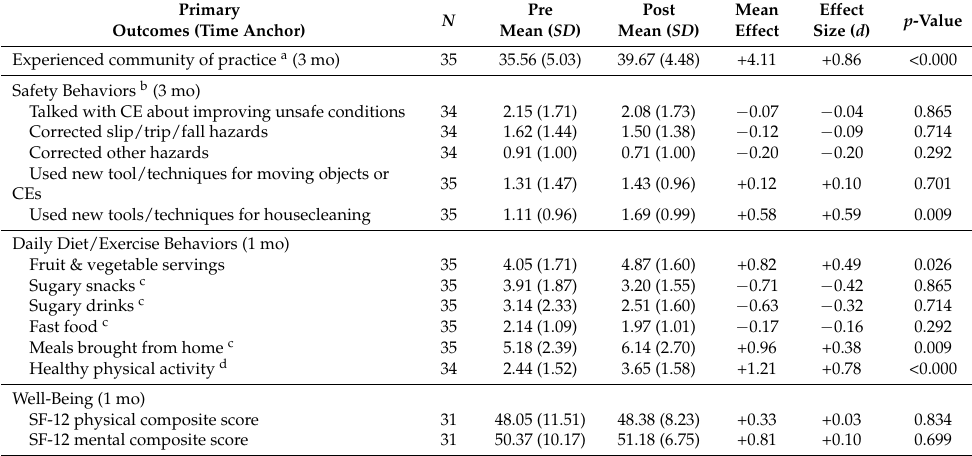
Table 3. COMPASS adaptation pilot intervention effects on primary